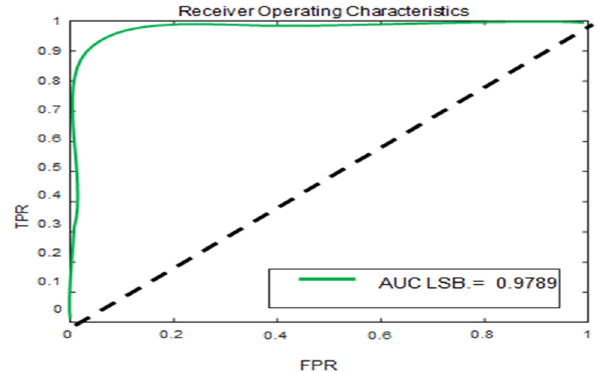
Figure 10: LSB agent - based steganography ’ s strong